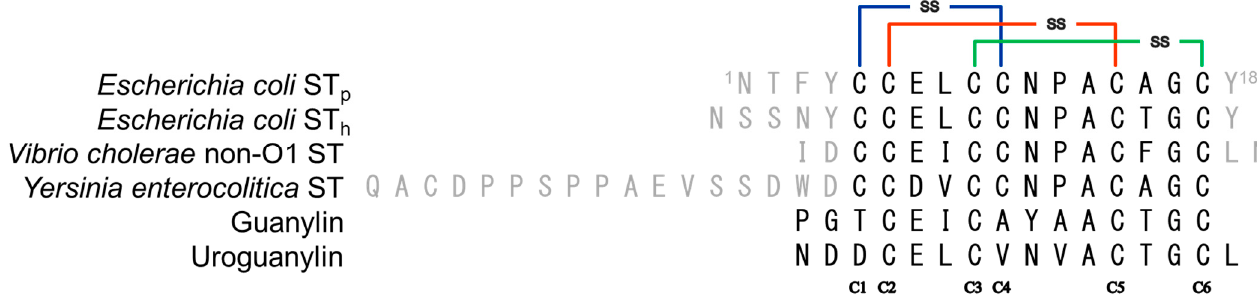
Figure 1. Amino acid sequences of the ST a -related peptides. Solid lines represent disulfide bonds.